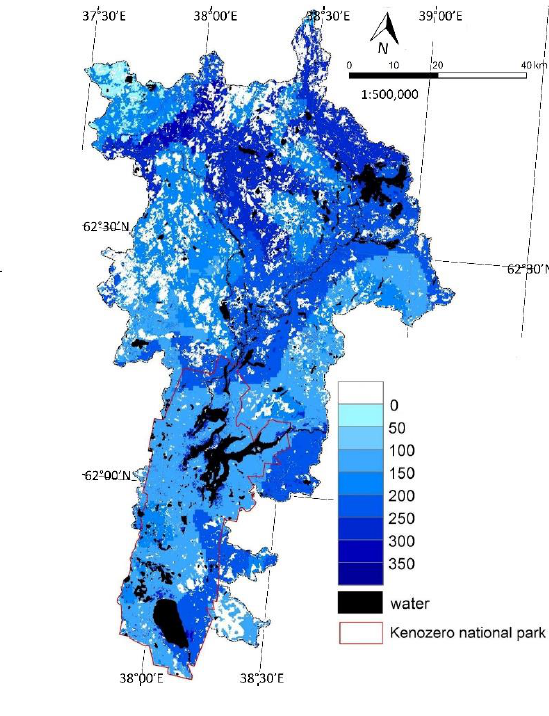
evapotranspiration by vegetation (mm/year).